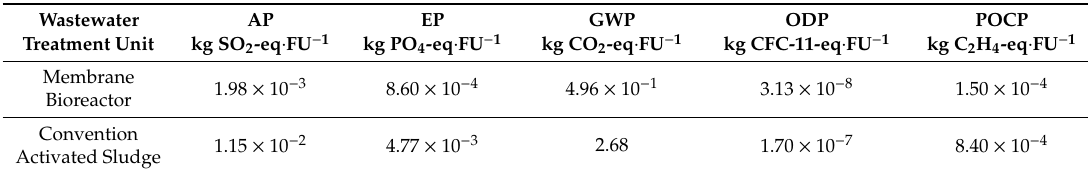
Table 4. Life Cycle Inventory Analysis (LCIA)